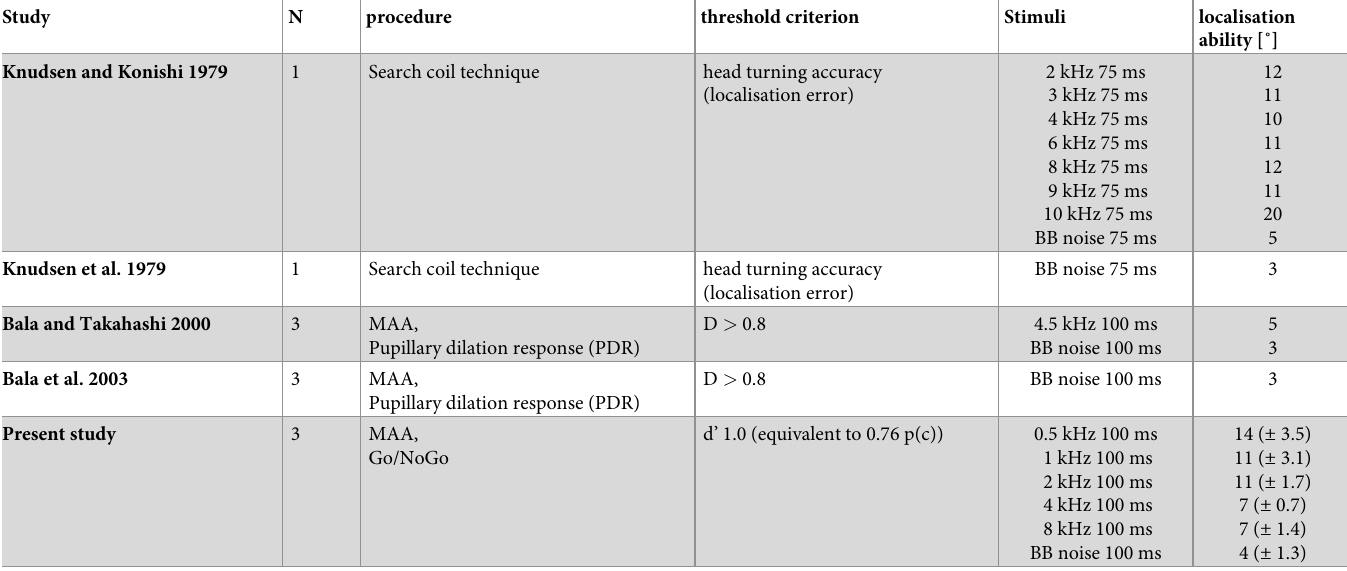
Table 3. Barn owl sound localisation performance for different stimulus types measured in selective